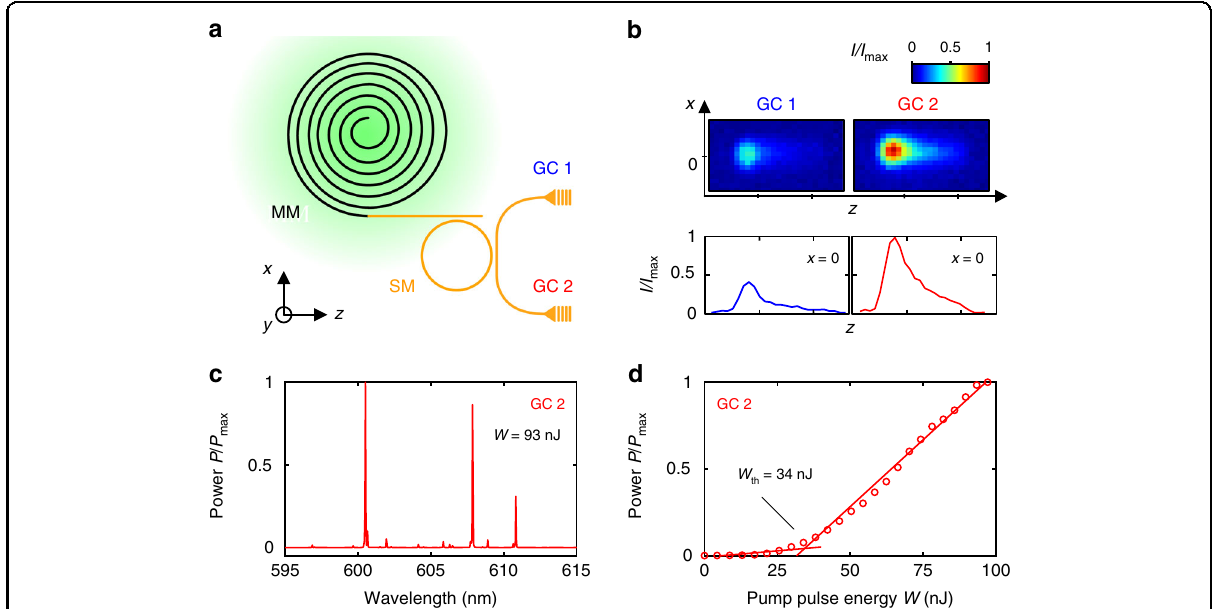
Fig. 3 Characterization of SiNOH laser. a SiNOH laser geometry: a multimode WG (MM, black, w = 500 nm) embedded in the gain medium is coiled into a spiral with an outer diameter of 200 µm.The arrangement offers a large overlap of the spiral WG with the Gaussian pump spot exhibiting a full-width half-maximum of 160 µm (green). The MM WG is tapered down to a single-mode (SM) WG subject to w = 300 nm (orange), which is evanescently coupled to a SM ring resonator ( Q = 5 × 10 3 ). The ring resonator is coupled to the SM output WG that guides the light to GC1 and GC2, which are both optimized for quasi-TE polarization. b Colour-coded intensity of the SiNOH laser light emitted from GC1 and GC2 (upper row) along with a cross-section of the emission pro fi le along the line of x = 0 (bottom row). The emission from the GC is recorded by a CCD camera (three-fold magni fi cation) and normalized to the maximum detected power intensity I max measured at GC2. By comparing these plots, we fi nd that the clockwise-propagating power in the ring is three times as high as the counter-clockwise-propagating power, which provides feedback into the pumped spiral. c Normalized emission spectrum of the SiNOH laser recorded under quasi-TE-polarization at GC2 (resolution bandwidth: 60 pm; integration time: 2 s). Three dominant lasing modes are shown. d Normalized laser output power as a function of the pump-pulse energy W . We fi nd a lasing threshold of